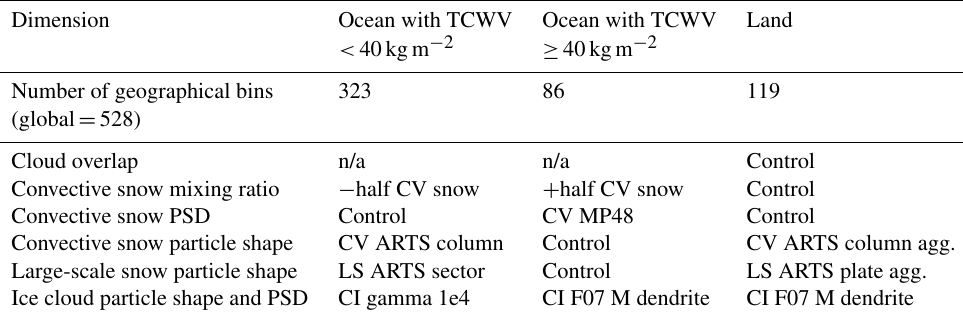
Table 6. Results of a situation-dependent parameter search. “n/a” means not applicable. Dimension Ocean with TCWV